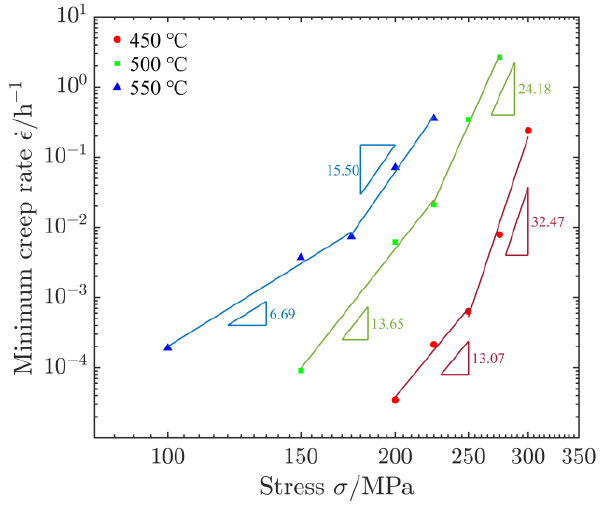
Figure 6. The relationship between the minimum creep rate and stress of CGI. Generally, according to Figure 6 and in combination with Equations (2) to (3), the parameters A 0 , B 0 , C 0 , Q A , Q B , Q C , p , n , and m can be determined by linear regression on the Arrhenius plots. However, in the region dominated by IDC, there was only the minimum creep rate corresponding to the low-stress region of 550 ◦ C, so the